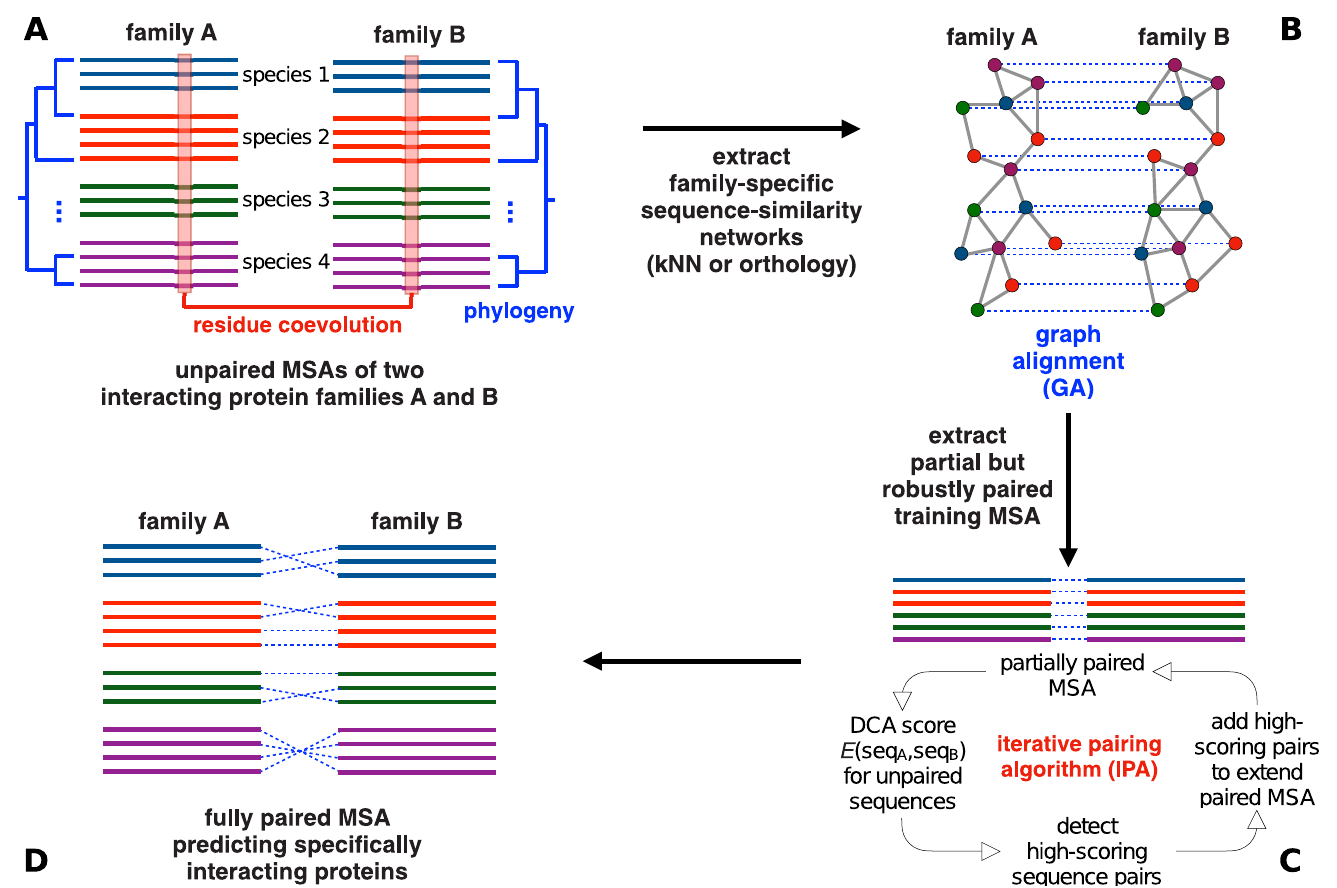
Fig 1. GA-IPA approach for paralog pairing between two interacting protein families. We show schematics to illustrate the key points of our approach (these schematics are conceptual and do not represent actual phylogenetic trees or similarity networks). (A) One starts from the separate MSAs of two interacting protein families A and B. Each species present in these MSAs may contain multiple paralogs in each family. Our goal is to infer which paralog in family A interacts with which paralog in family B. As indicated, two types of information will be used: phylogeny and residue coevolution. (B) We first construct a sequence-similarity network, specifically a k nearest-neighbor (kNN) or an orthology network, for each of the two families. These two networks are aligned to find a pairing of the sequences that maximises the similarity of the two networks, while only allowing pairs within the same species. Repeated runs of a stochastic graph-alignment (GA) algorithm based on simulated annealing allow to identify robust pairs, which are consistently paired across GA runs. (C) This partial but robustly paired MSA is used as an input to the iterative pairing algorithm (IPA) based on residue coevolution as detected by DCA. IPA iteratively extends the paired MSA until all sequences are paired. (D) The output full co-MSA is our prediction for the interacting protein pairs between families A and B.